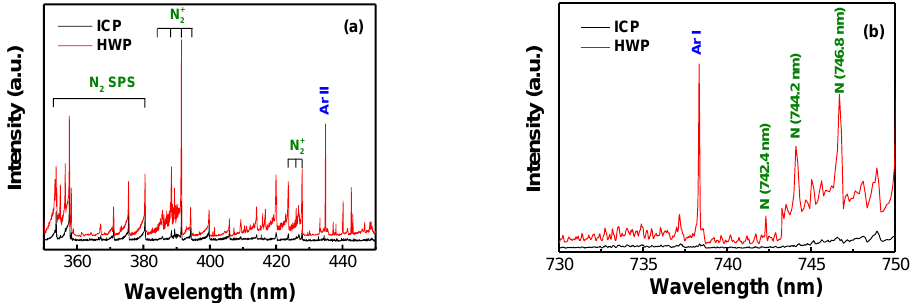
Figure 7. OES spectrum observed during plasma nitriding process in: ( a ) wavelength range 350 – 450 nm, ( b ) wavelength range 730 – 750 nm.